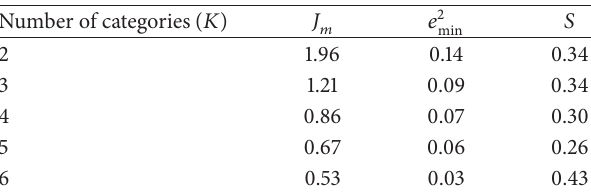
Table 5: The results of the 𝑆 -test.